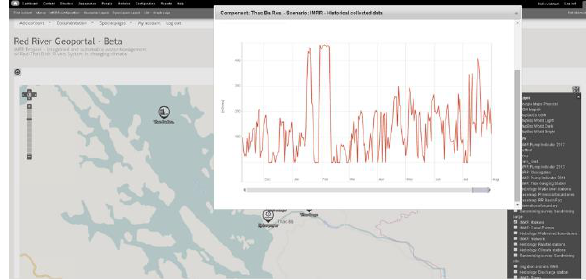
Figure 4. Red-Thai Binh rivers geoportal user interface